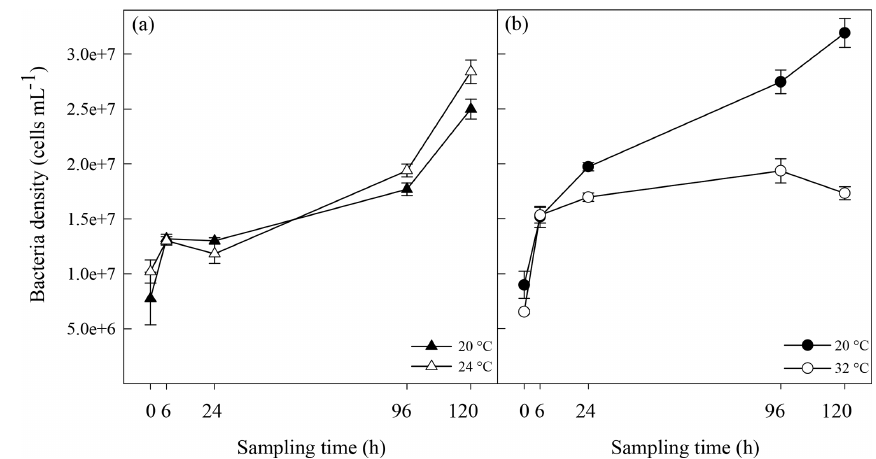
Figure 5. Bacterial cell abundance in A. minutum cultures in experiment 1 (20 and 24 ◦ C) (a) and experiment 2 (20 and 32 ◦ C) (b) ; aver- age ± SE, n = 4.